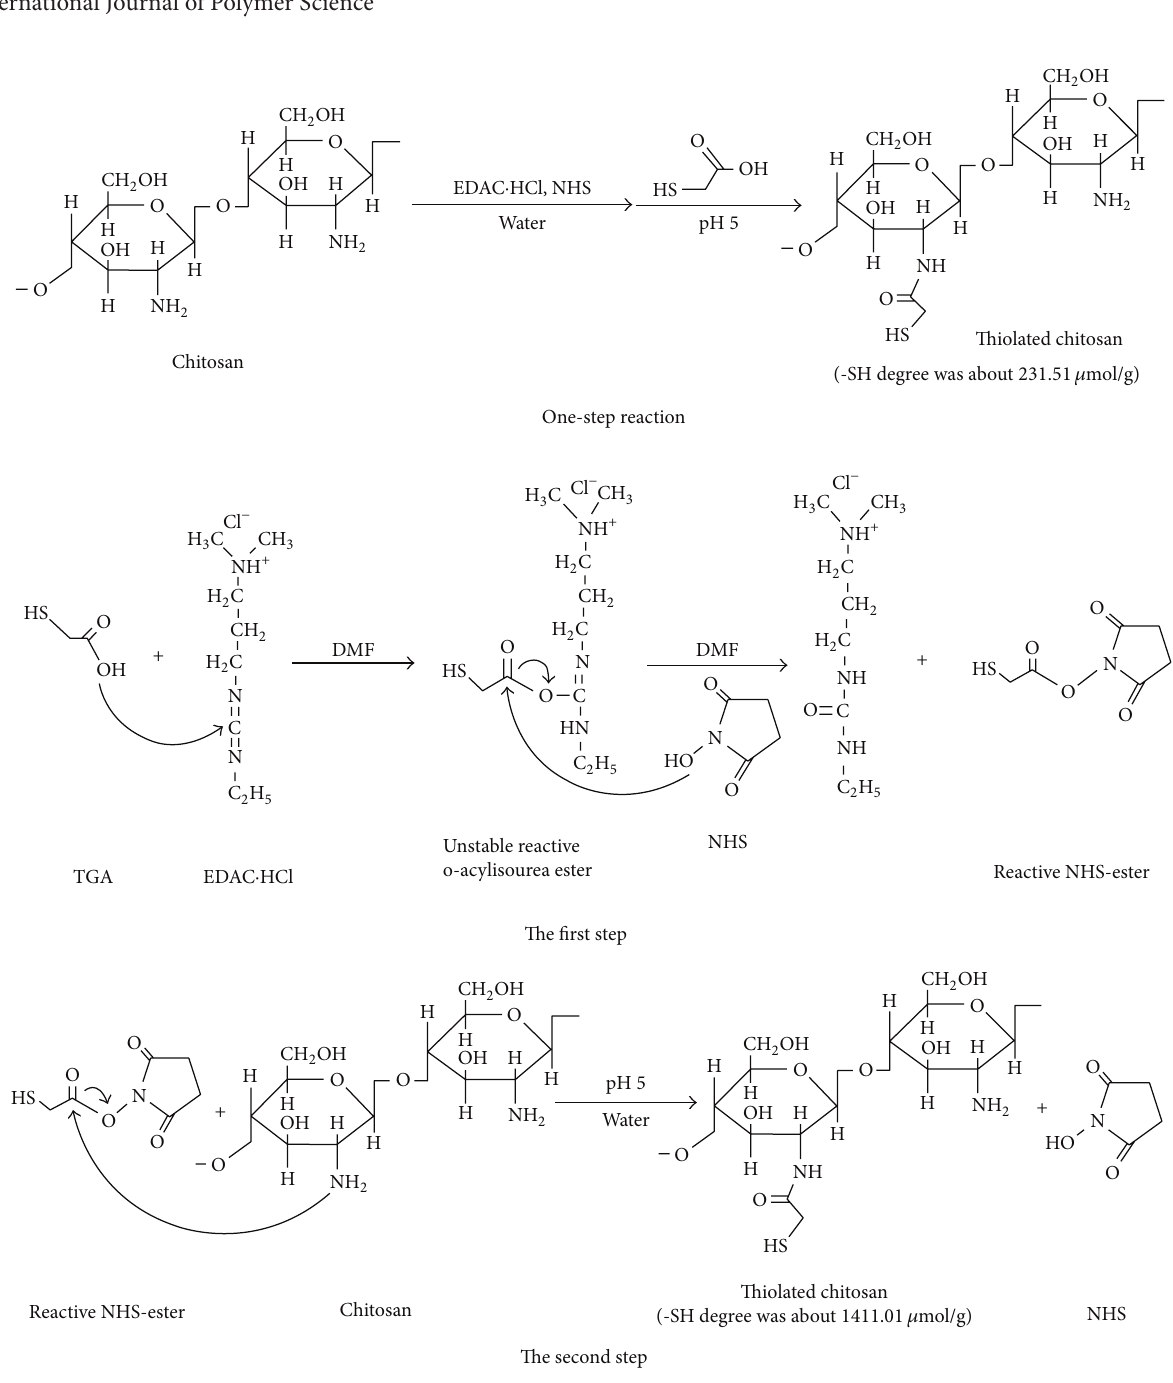
Figure 1: Process for thiolation of